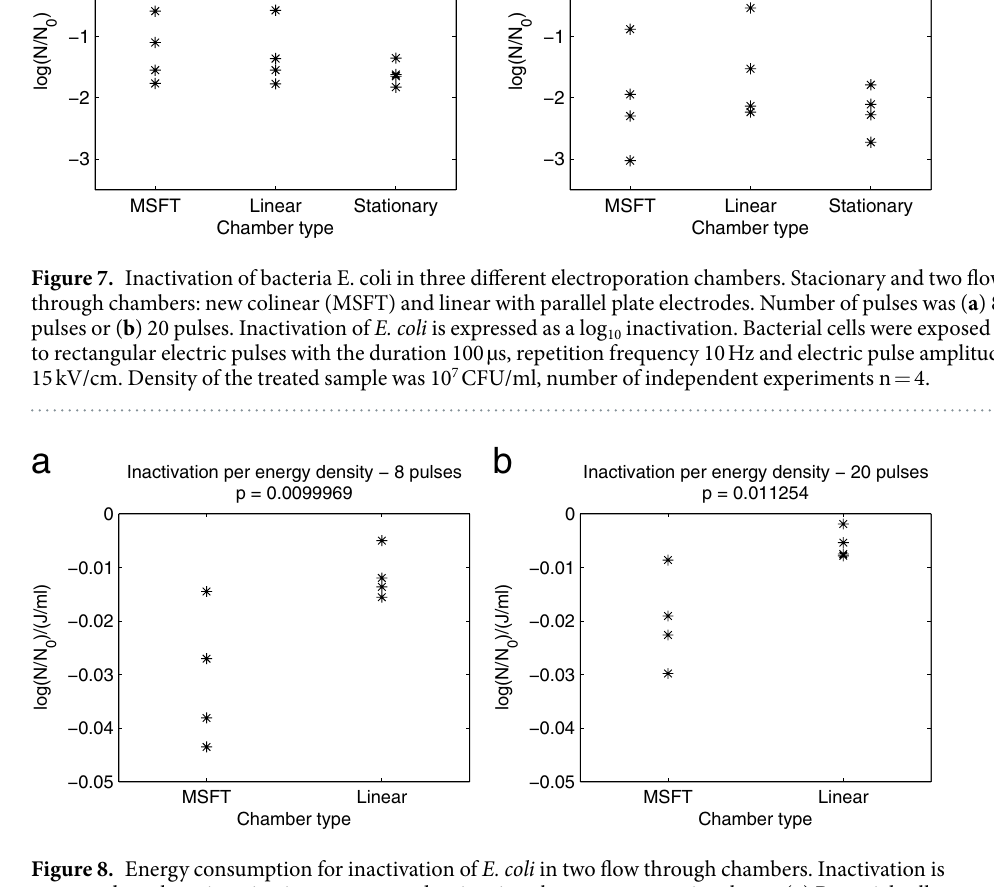
Figure 8. Energy consumption for inactivation of E. coli in two flow through chambers. Inactivation is expressed as a log 10 inactivation per energy density given by energy per unit volume. ( a ) Bacterial cells were exposed to 8 or ( b ) 20 rectangular electric pulses. The duration was 100 µ s, repetition frequency 10 Hz and electric pulse amplitude 15 kV/cm in MSFT and linear flow through chambers. Cell concentration of the treated sample was 10 7 CFU/ml number of independent experiments n =